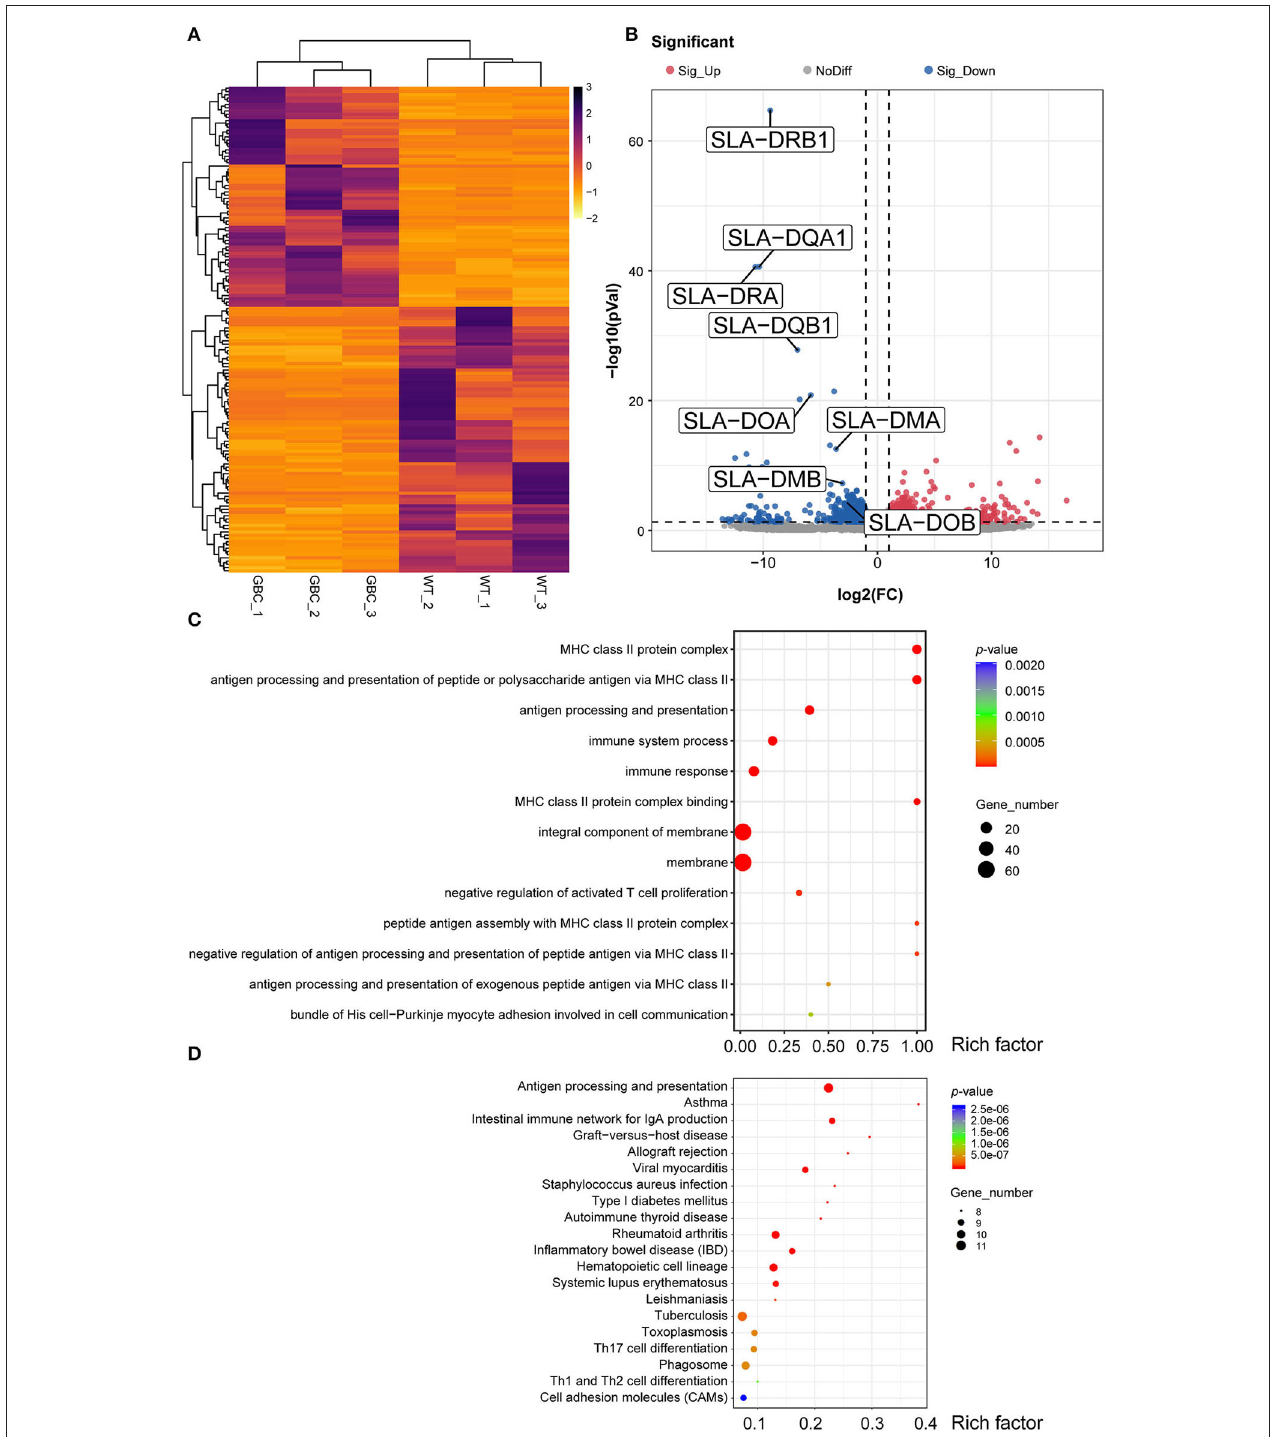
FIGURE 6 | Transcriptome profiling of PBMCs in GBC-modified pig’s spleen. (A) Heatmap of 150 significant DEGs ( P < 0.05) between GBC-modified and WT pigs. (B) A volcano plot between GBC modified and WT pigs, including 68 upregulated genes and 82 downregulated genes. (C) The top 13 Gene Ontology (GO) enrichments of DEGs. The y -axis is the name of each category, the x -axis is their rich factor. Rich factor = numbers of genes at a category/total numbers of genes at GO analysis. (D) The top 20 Kyoto Encyclopedia of Genes and Genomes (KEGG) pathways of DEGs. The y -axis is the name of each category, and the x -axis is their rich factor. Rich factor = numbers of genes at a pathway/total numbers of genes at KEGG analysis. The number of genes enriched in each category was shown at the size of each circular.